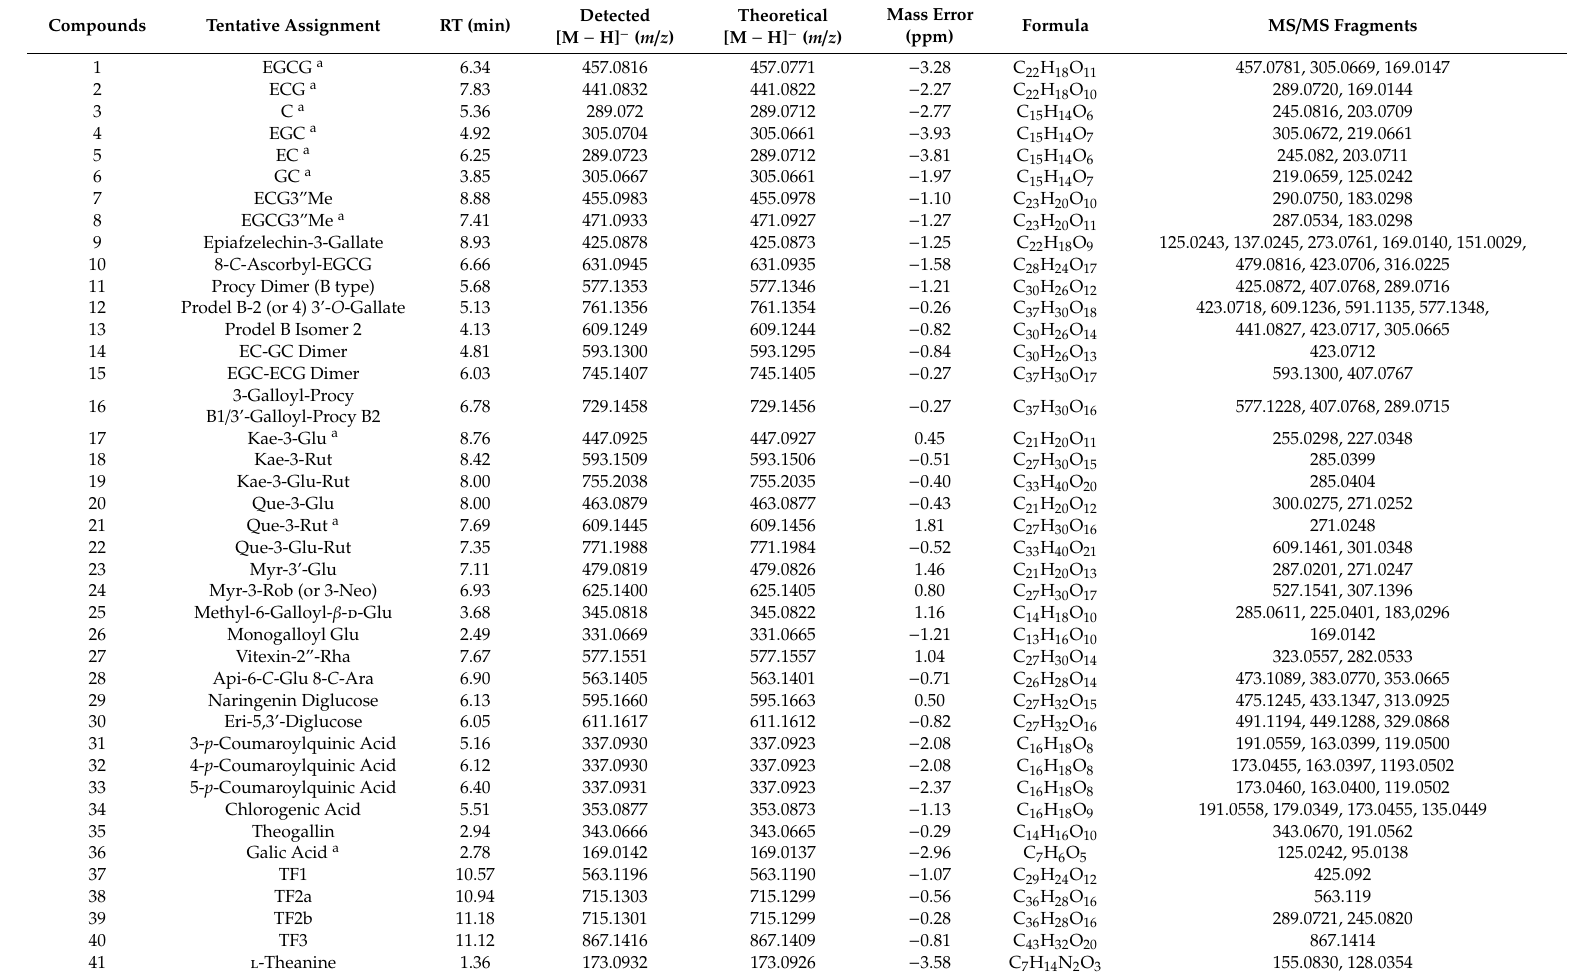
Table 1. Metabolites putatively identified in four tea types by